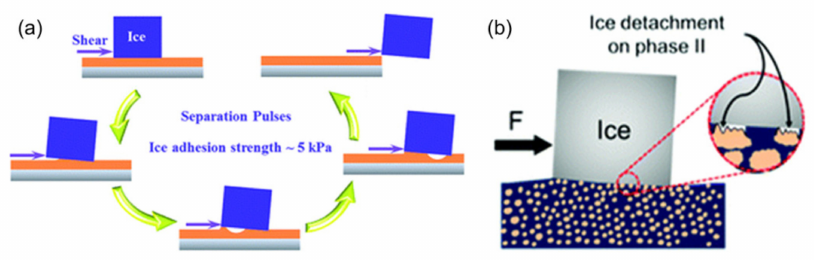
Figure 5. ( a ) Schematic illustrating the separation of ice from PDMS gels via separation pulses. During a horizontal shear, air can be trapped into air cavities, and these air cavities can be propagated via separation pulses; ( b ) stress-localized viscoelastic icephobic material consists of two phases: silicon elastomer (Phase I) and silicon-based organogel (Phase II). The crack forms at the coordinate of phase II with minimal forces. Panel ( a ) reproduced with permission from Ref. [41], Copyright 2016, the Royal Society of Chemistry; panel ( b ) reproduced with permission from Ref. [143], Copyright 2019, the Royal Society of